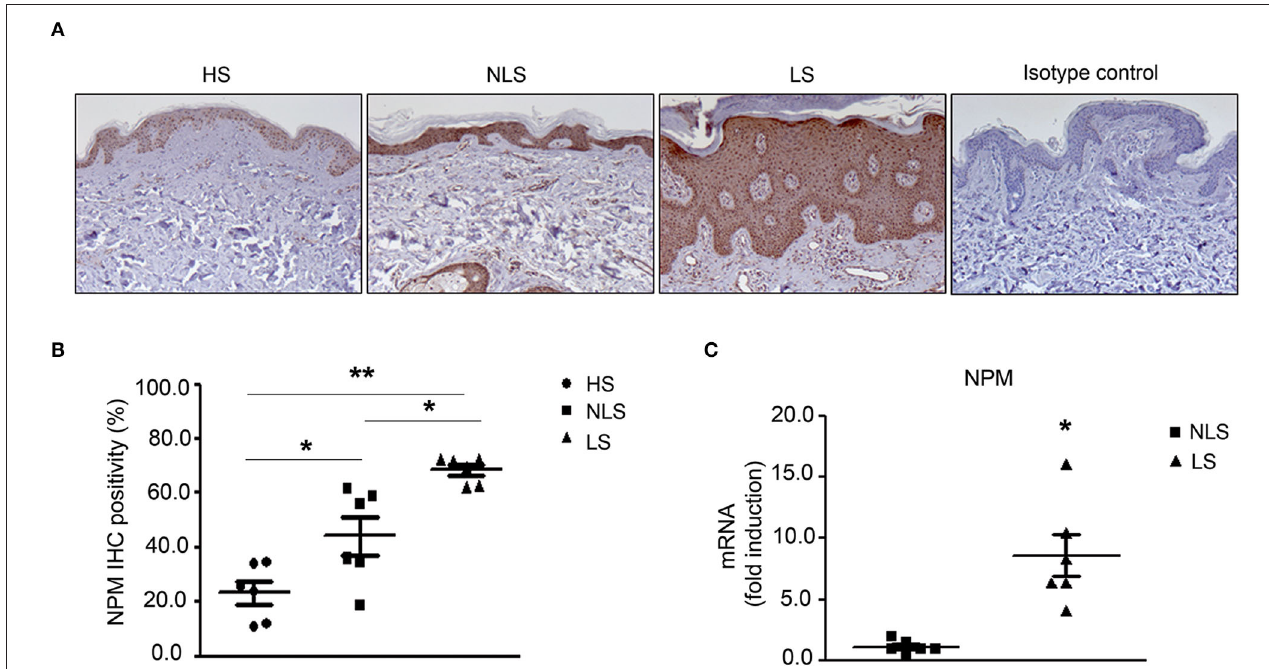
FIGURE 1 | NPM protein level is increased in Pso skin. (A) Representative immunohistochemistry (IHC) of NPM. NPM protein level increased in human psoriatic patient paraffin-embedded biopsies of lesional skin (LS) compared to non-lesional skin (NLS) and biopsies of the skin of healthy individuals (HS). Rabbit IgG isotype control was used as a negative control. (B) IHC quantification of NPM of LS compared to NLS and HS. IHC was quantified by Image J color deconvolution of three adjacent fields for each section. Graph shows the IHC quantification as IHC positivity area expressed in percentage ( n = 6; * p < 0.05, ** p < 0.01). (C) NPM mRNA expression levels were increased in LS compared to NLS ( n = 5; * p <